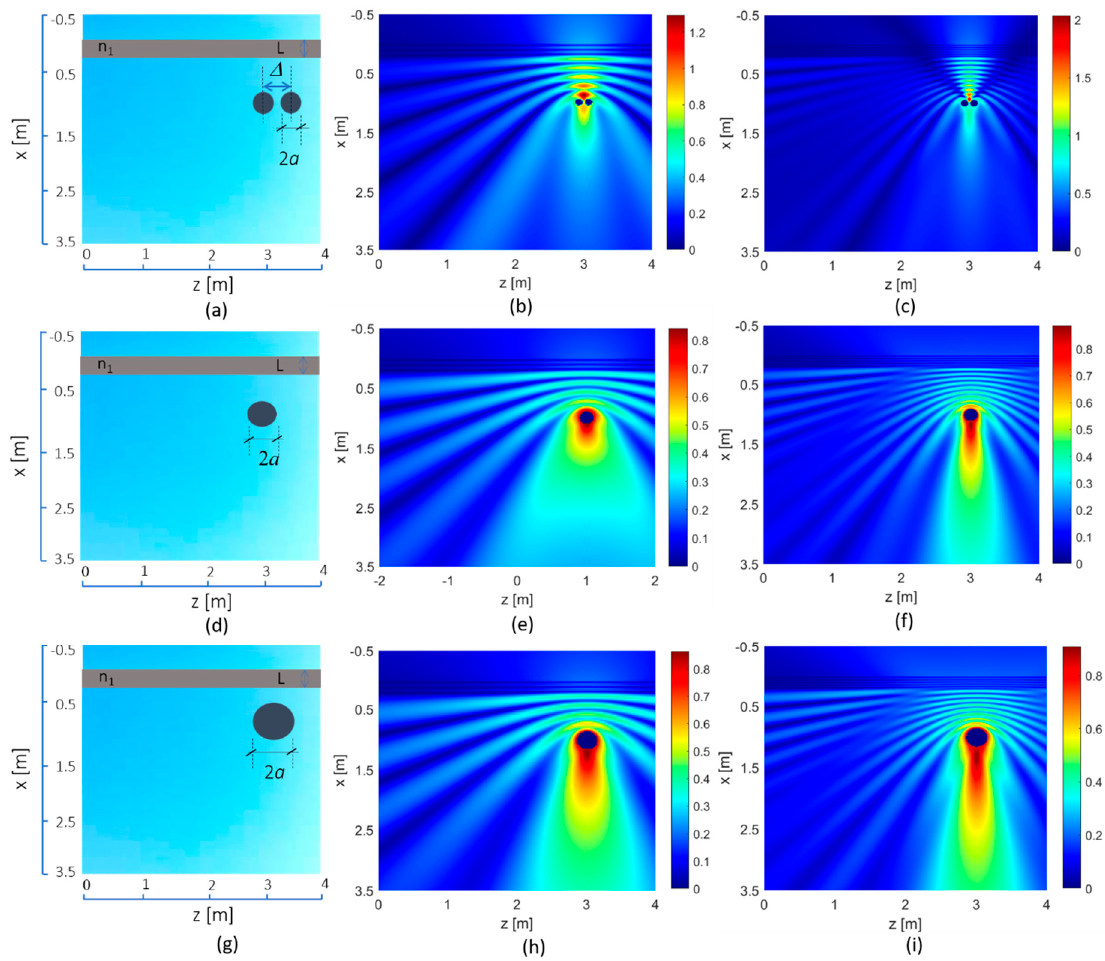
Figure 4. Two-dimensional field maps of the total electric field with targets modeled as PEC and plane wave excitation in TM polarization and normal incidence [20]: ( a ) knee ( a = 6 cm) at 1 GHz ( b ) and 2 GHz ( c ); ( d ) head ( a = 10 cm) at 1 GHz ( e ) and 2 GHz ( f ); ( g ) thorax ( a = 15 cm) at 1 GHz ( h ) and 2 GHz ( i ). The dielectric layer has thickness L = 20 cm and ε r1 = 4.